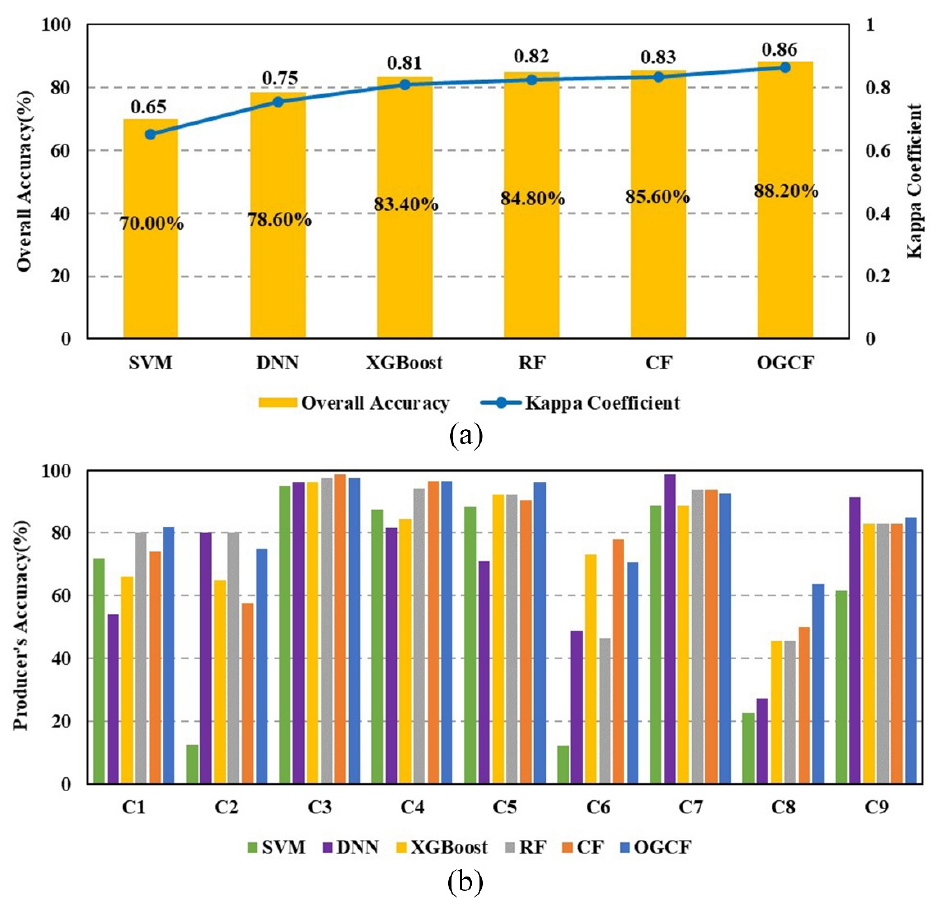
Figure 6. The accuracy assessment of several classification methods, including support vector machine (SVM), deep neural network (DNN), extreme gradient boosting (XGBoost), random forest (RF), cascade forest (CF), and object-based gcForest (OGCF). ( a ) The overall accuracy and kappa coefficient of different classification methods. ( b ) The producer’s accuracy for each land cover by using different classification methods. C1–C9 are the class codes that represent different land cover classes (see Table 2).